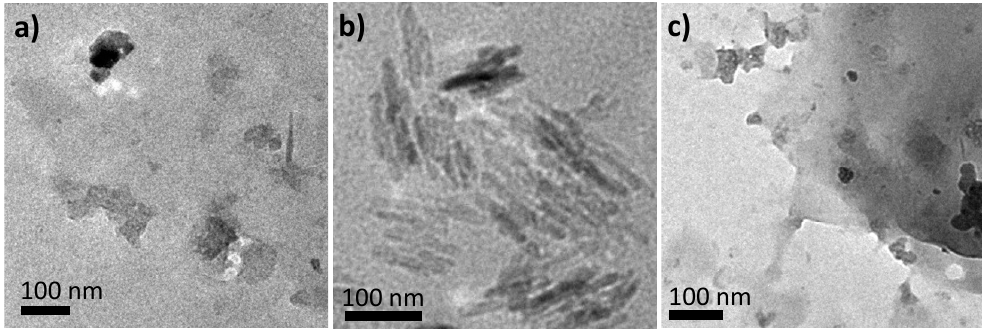
Figure 6. Transmission electron micrographs of samples prepared from ( a ) 1 /[Au(CN) ] − and ( c ) 3 /[Au(CN) ] − in DI water solutions. Samples are not ( b ) 2 /[Au(CN) 2 2